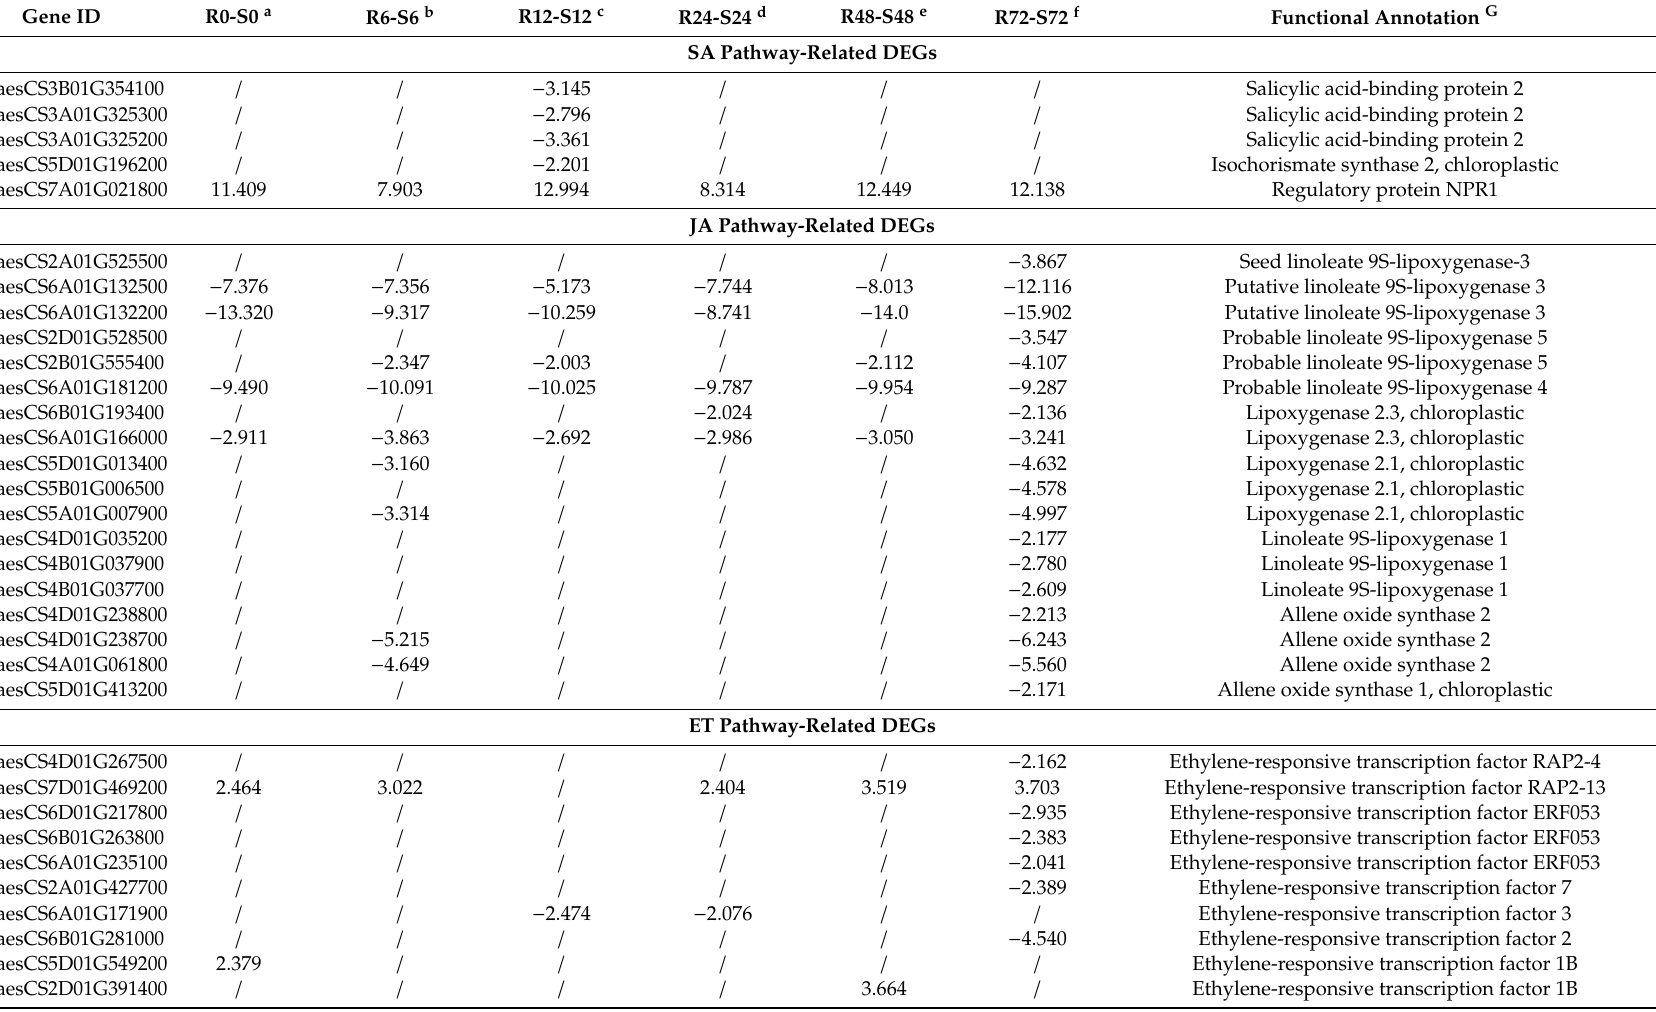
Table 2. List of DEGs involved in hormone pathways between L658 and L958 at each time